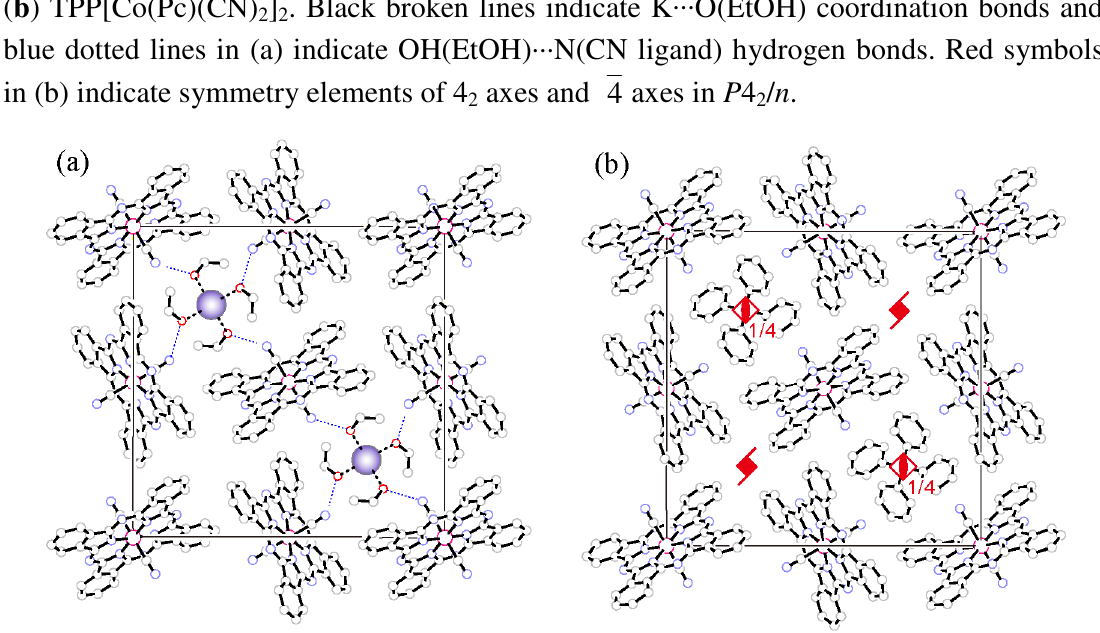
Figure 1. Projections along the c axis of ( a ) K[Co(Pc)(CN) ] . Black broken lines indicate K...O(EtOH) coordination bonds and ( b ) TPP[Co(Pc)(CN) 2 2 blue dotted lines in (a) indicate OH(EtOH)...N(CN ligand) hydrogen bonds. Red symbols in (b) indicate symmetry elements of 4 axes and axes in P 4 2